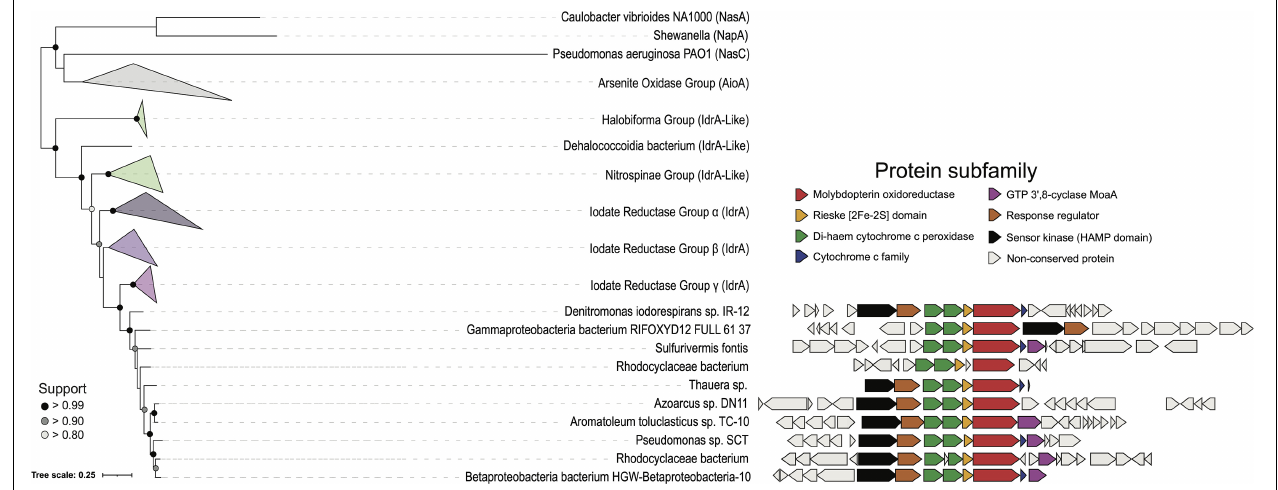
FIGURE 3 | A phylogenetic tree representing the major groups of IdrA. Collapsed clades are represented as triangles to show the interclade distance. IdrA clade containing all cultured representatives of DIRM is expanded. Gene neighborhoods show ± 10 genes from IdrA when present. Genes are colored based on Pfam annotation if the protein family shows up in more than 50% of the clade’s